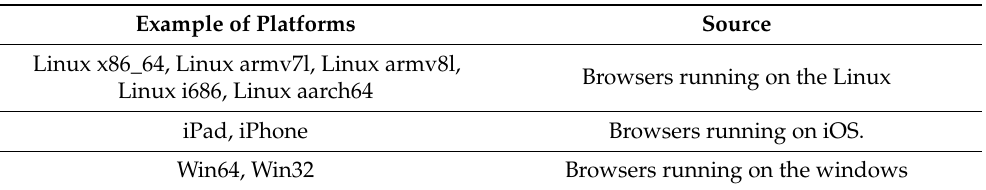
Table 4. Examples of platforms and their sources retrieved from the designated website.